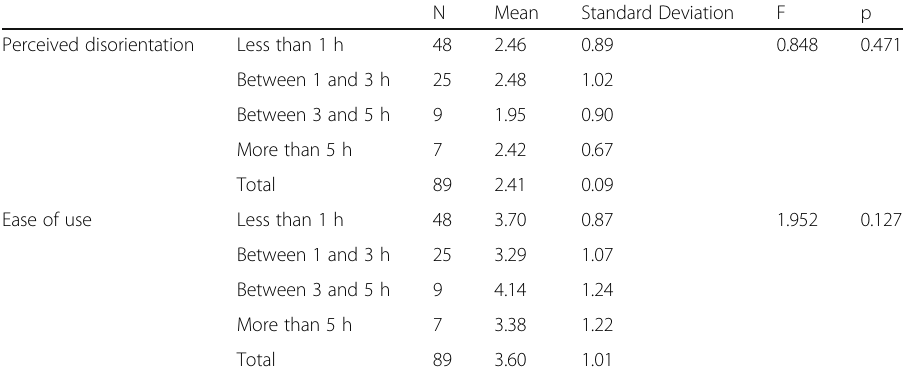
Table 8 ANOVA results for effect of daily average internet use to perceived disorientation N Mean Standard Deviation F p Perceived disorientation Less than 1 h